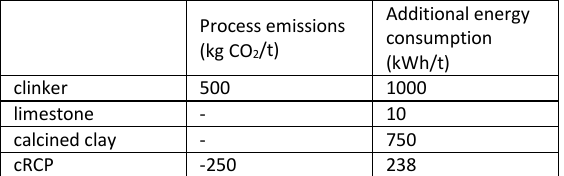
Table 1. Assumed process emissions at material level and approximate energy consumption for the cement constituents